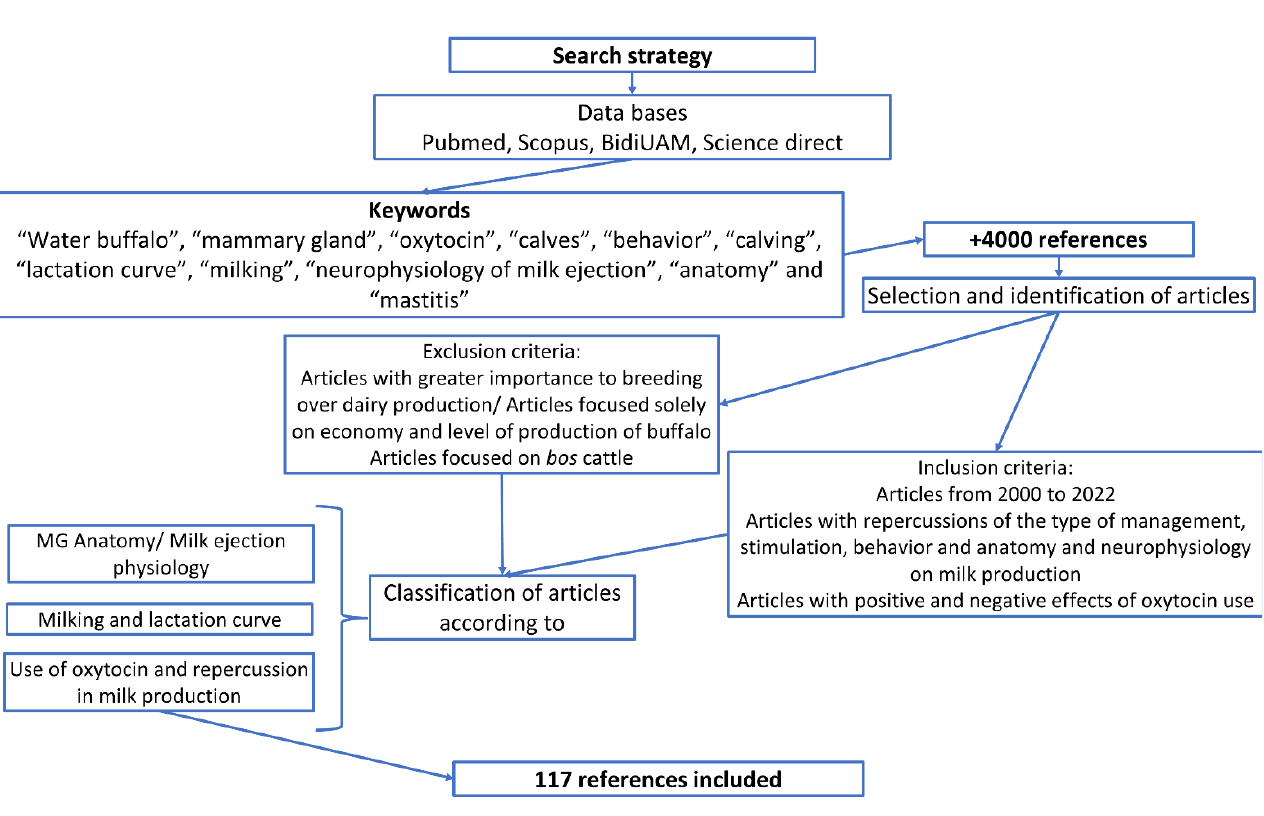
Figure 1. The methodology applied in this manuscript with the selection and exclusion criteria focused on fulfilling the objective of this manuscript.